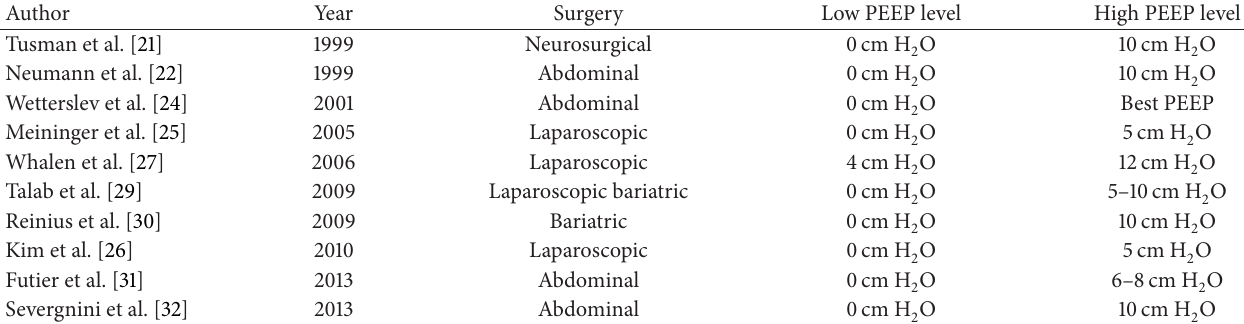
Table 1: Main characteristics of RCTs for surgical patients included in this